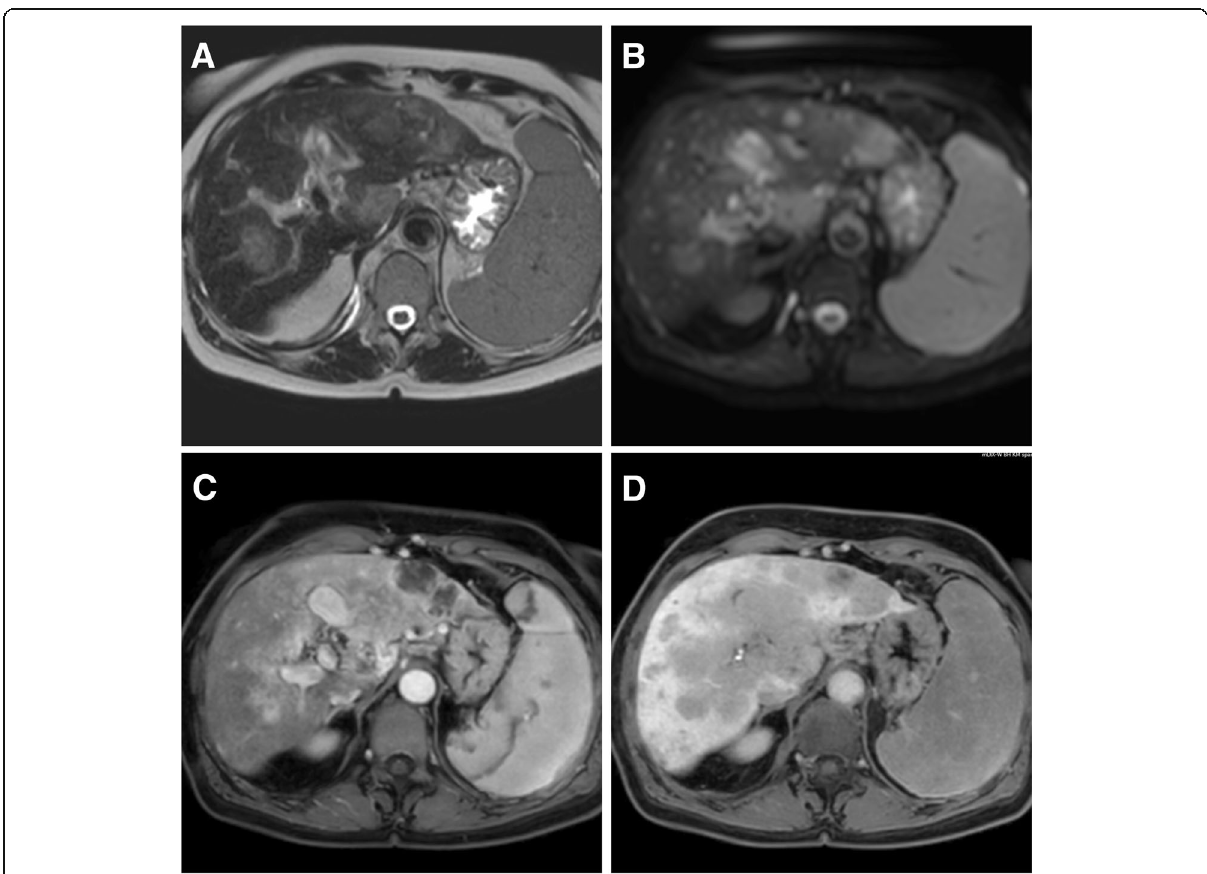
Fig. 7 Epithelioid hemangioendothelioma of the liver in a 18-year-old woman. MR images depict diffuse spread of typical EHE tumor nodules over the entire liver. T2w ( a ), diffusion-weighted imaging ( b ), Dixon fat-water imaging in the early ( c ), and late phase ( d ) after administration of gadoxetic acid. Due to accompanying liver cirrhosis (child B), the patient rapidly developed progressive liver failure and could not undergo surgery or systemic